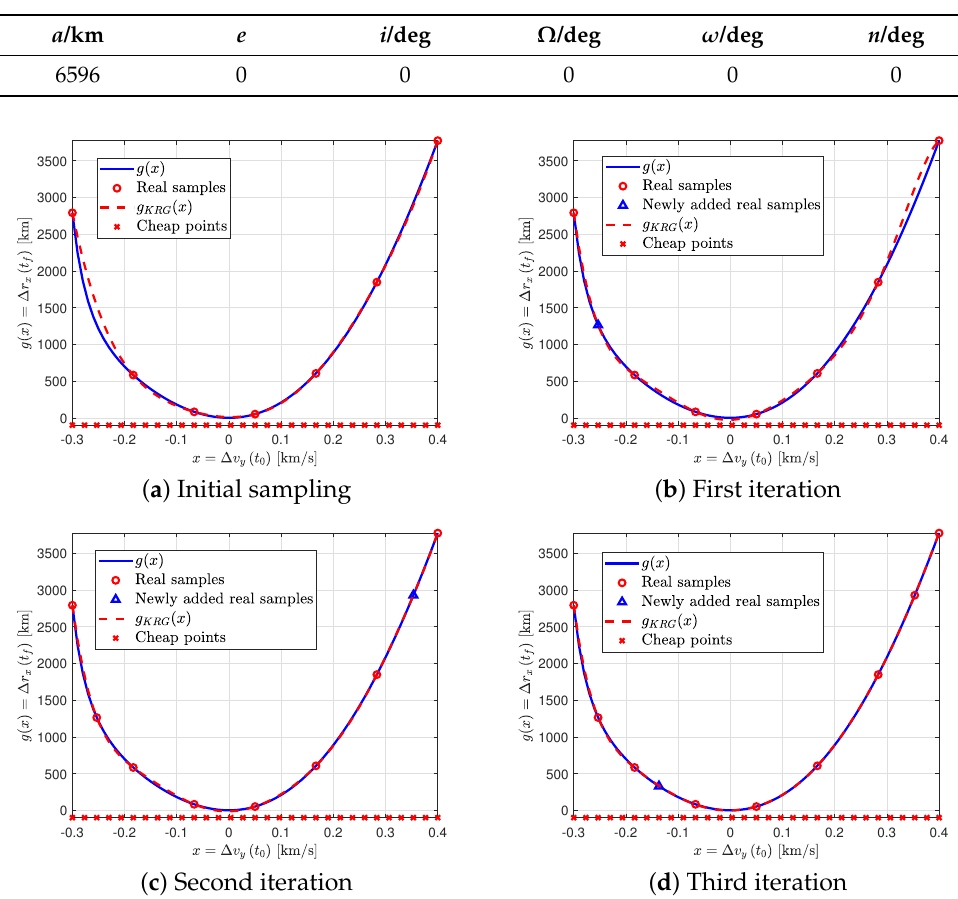
Table 3. Elements of the nominal orbit of LEO case.